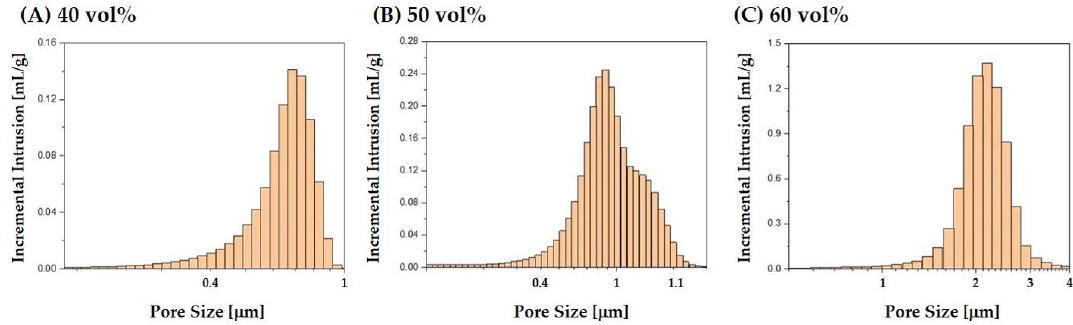
Figure 6. Size distributions of the micropores in the CaP frameworks obtained using a range of camphene-camphor amounts: ( A ) 40 vol %, ( B ) 50 vol %, and ( C ) 60 vol %.